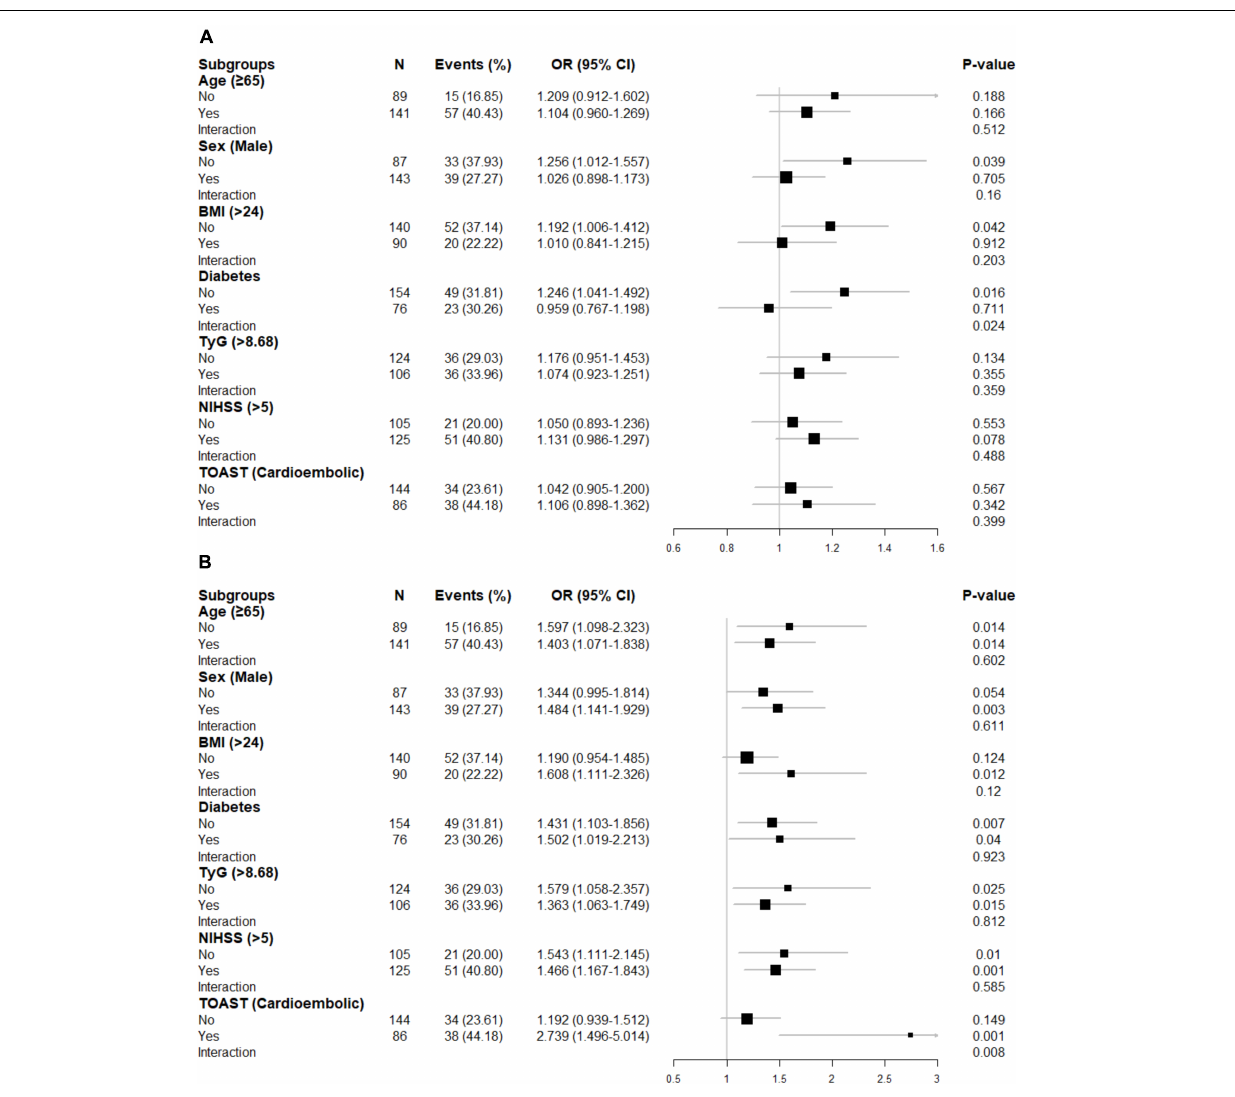
FIGURE 3 | Subgroup analyses for the risk of poor functional outcome by (A) SHR1 defined as [admission RBG (mmol/L)]/[HbA1c (%)], (B) SHR2 defined as [FBG (mmol/L)]/[HbA1c (%)]. The above model adjusted for age, sex, current smoking, hyperlipidemia, atrial fibrillation, prior stroke, systolic blood pressure (SBP), and NIHSS at admission. In each case, the model is not adjusted for the stratification variable. BMI, body mass index; TyG, triglyceride-glucose index; NIHSS, National Institutes of Health Stroke Scale score; TOAST, Trial of Org 10172 in Acute Stroke